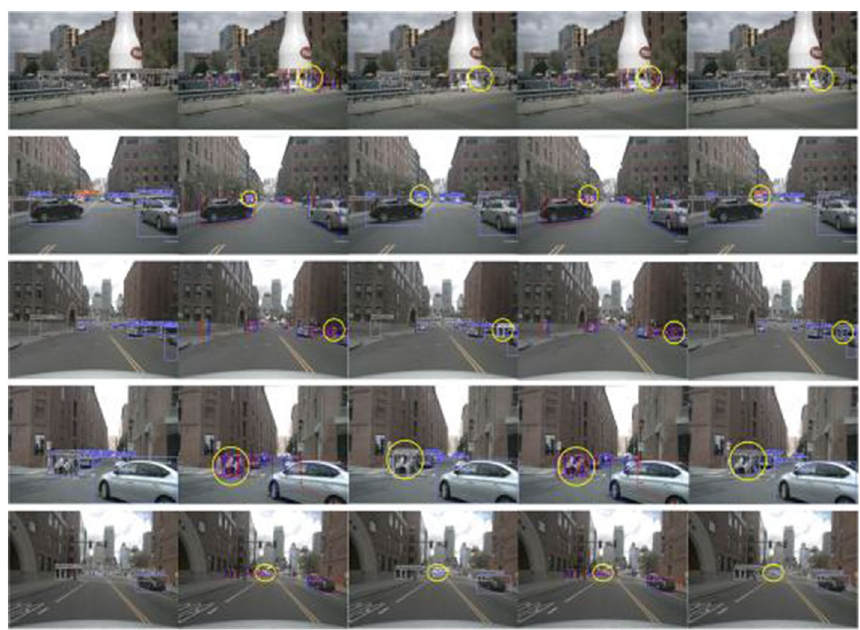
Fig. 7 Experimental effect of error detection compared with the baseline model is plotted.The first column is the estimated depth value on the image, which can visualize the specific target on the image and facilitate the experimental comparison effect demonstration; the second column is the 3D block diagram of the target detected by the baseline model; the third column is the specific classification and detection effect diagram of the target detected by the baseline model, which can directly reflect the target detection effect; the fourth column is the 3D block diagram of the target of our proposed CenterTransFuser model; the fifth column is the specific target classification and detection effect diagram obtained by our